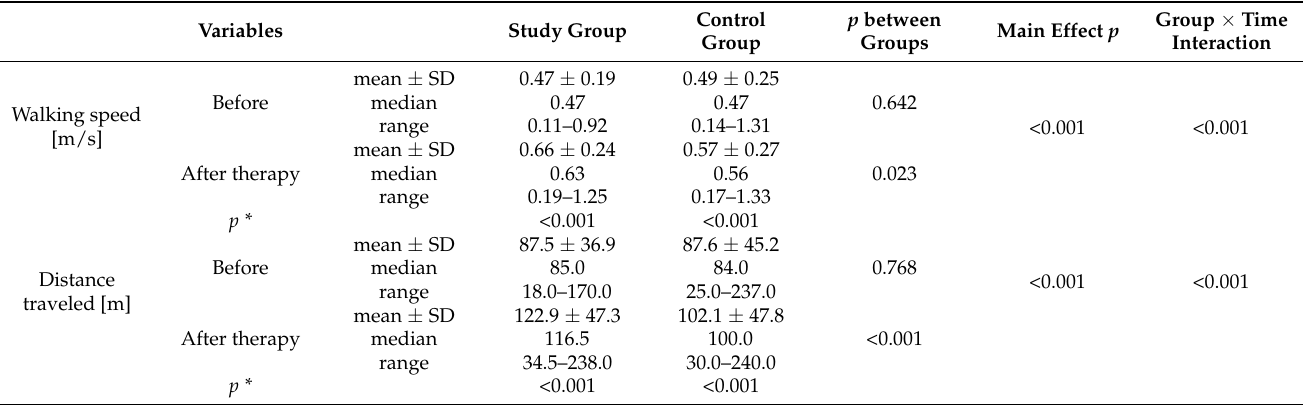
Table 3. Walking speed and distance traveled results for study and control groups prior to and following